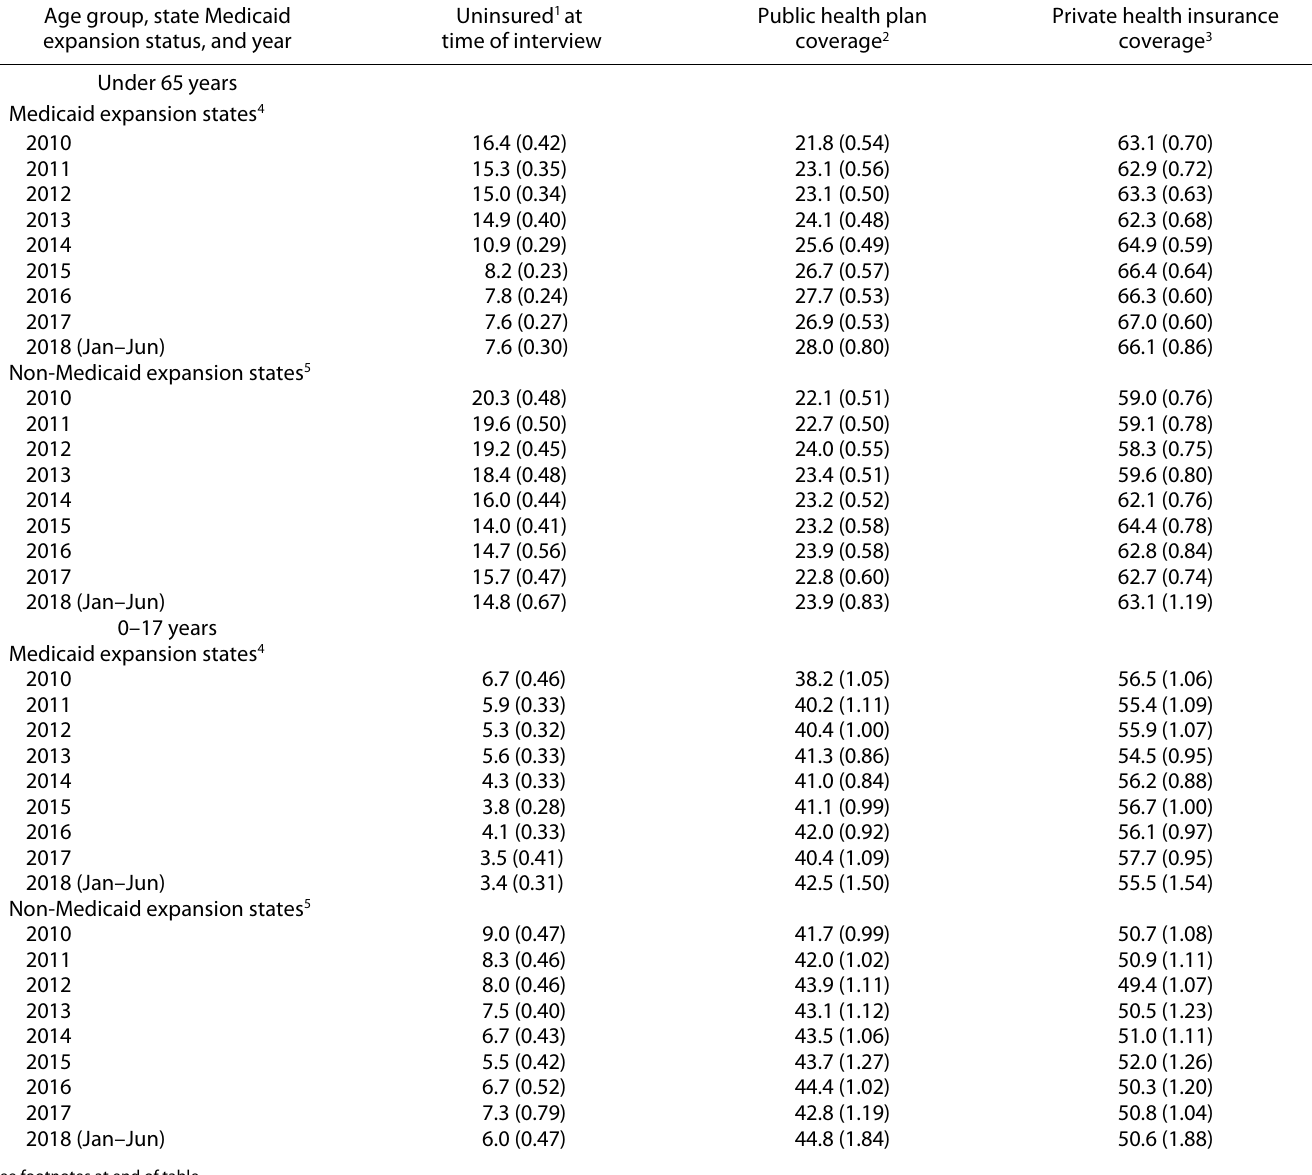
Table XIII. Percentages (and standard errors) of persons under age 65 who lacked health insurance coverage, had public health plan coverage, and had private health insurance coverage at the time of interview, by age group, state Medicaid expansion status,